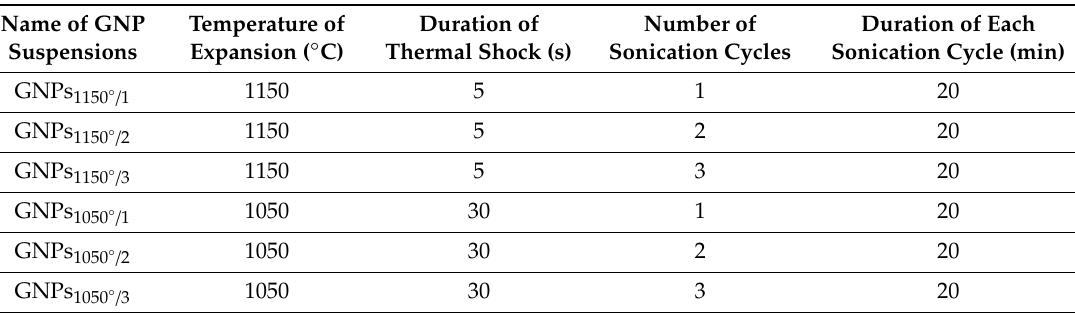
Table 1. Preparation of GNP